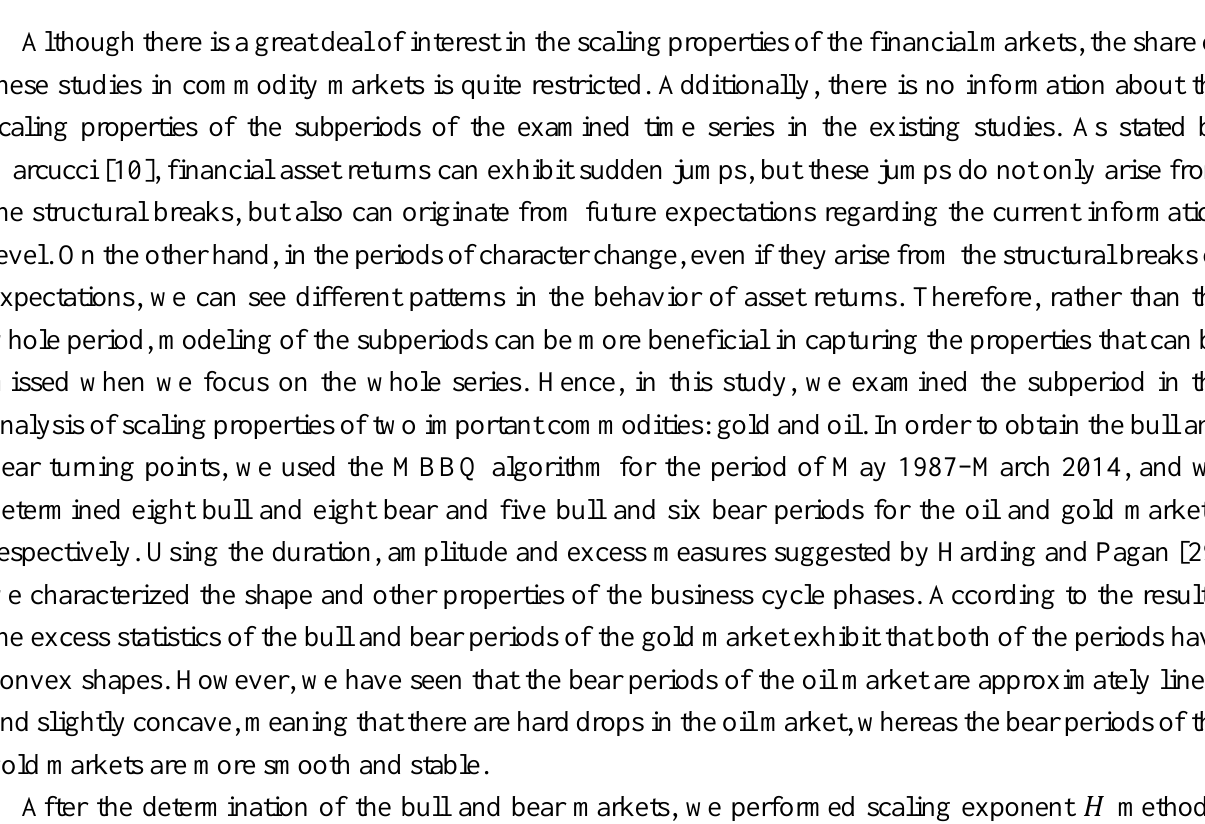
results of the bull and bear periods of the gold 𝐻𝐻